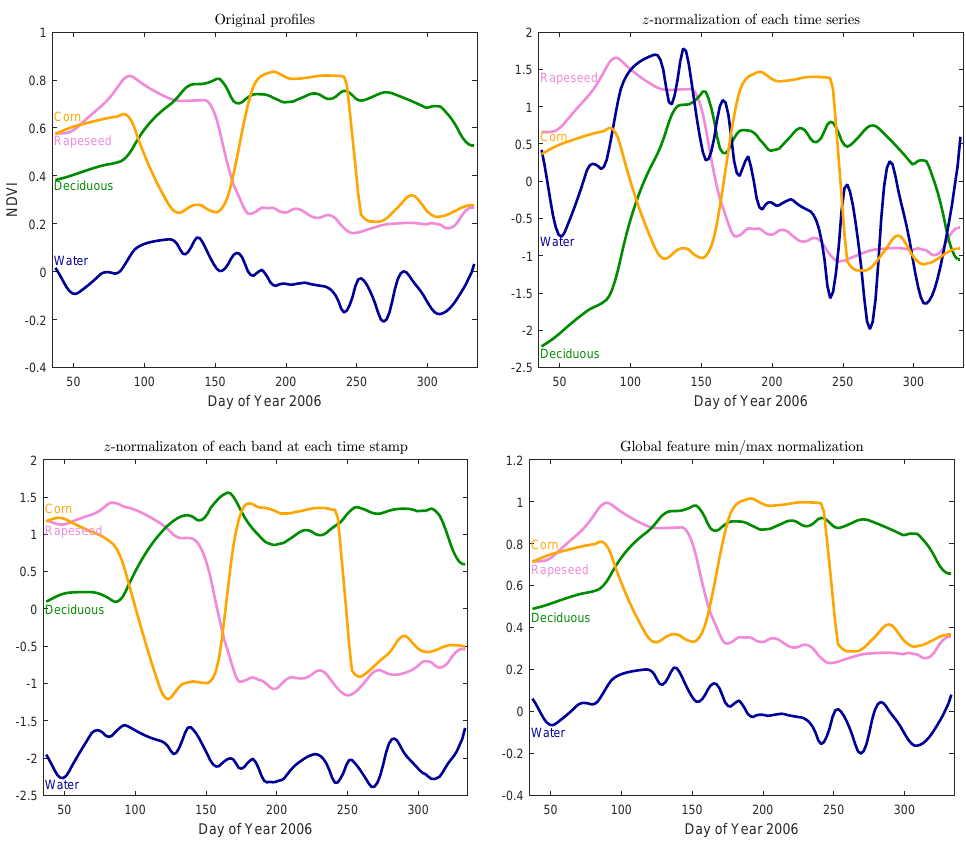
Figure 7. Three types of normalization of four Normalized Difference Vegetation Index (NDVI) temporal